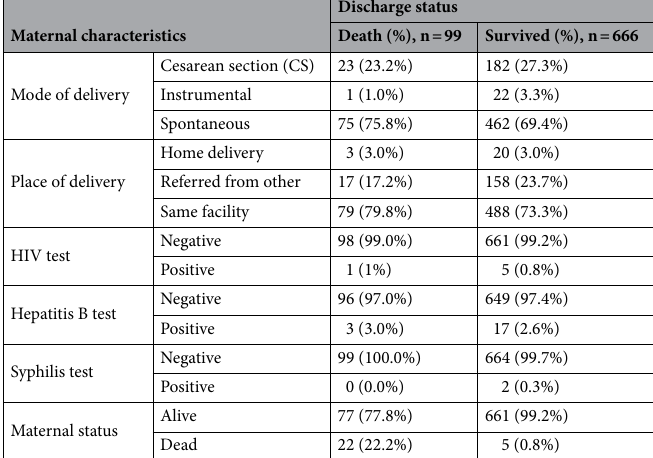
Table 2. Maternal characteristics of neonates admitted to NICU of Shiek–Hassen Referral Hospital from May 2019–May